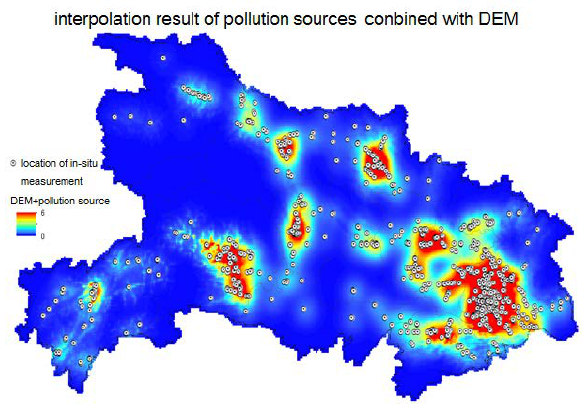
Figure 3 map of pollution sources